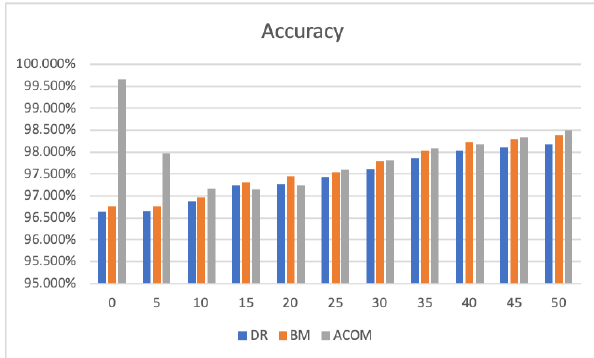
Figure 6. Accuracy Comparison of ACOM, BM, and DR